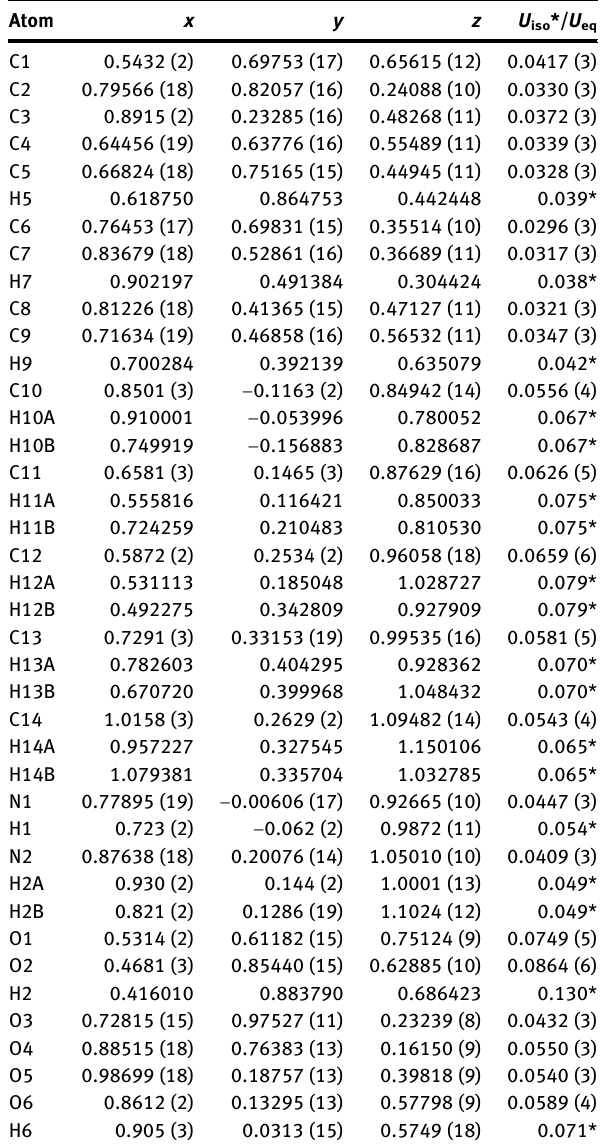
Table  : Fractional atomic coordinates and isotropic or equivalent isotropic displacement parameters (Å 